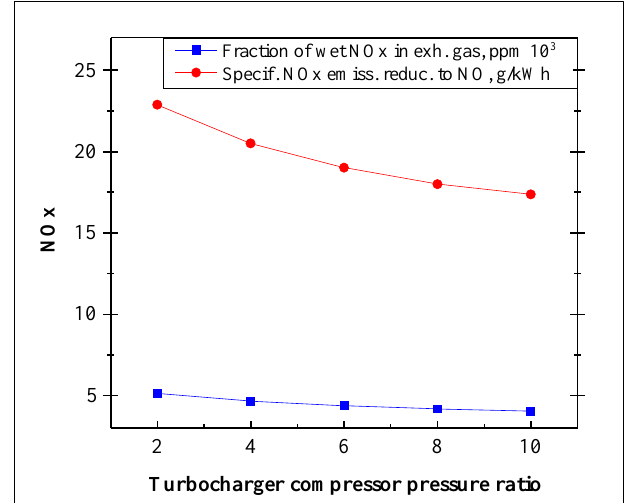
Figure 7. NOx emissions for the